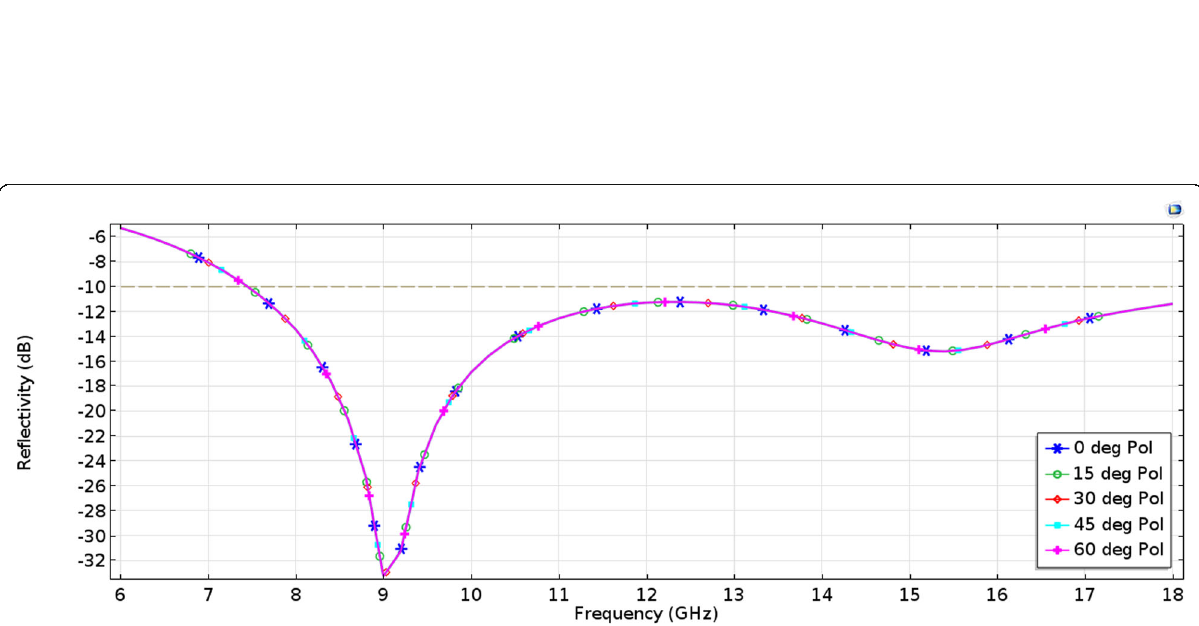
Fig. 11 Simulated reflectivity plots of different polarization angles at normal incidence for optimized